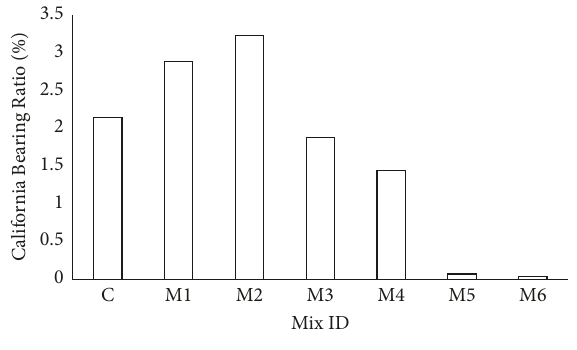
Figure 6: CBR values of soaked soil samples.